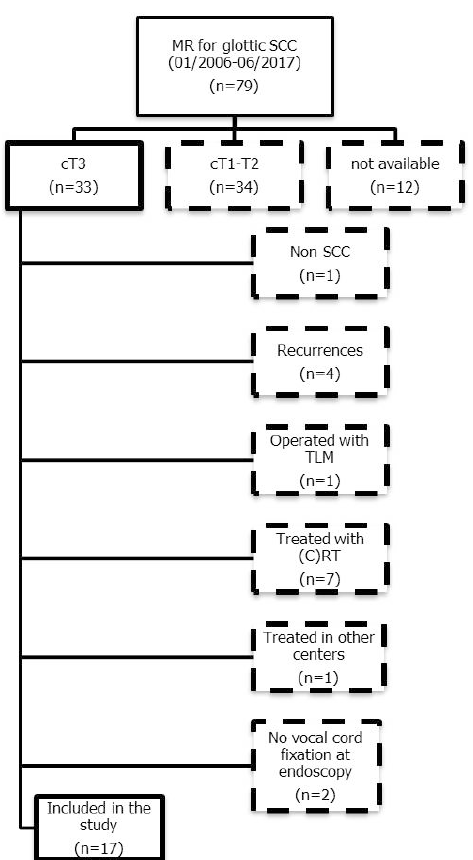
Figure 2. Selection schema: flow chart of patient enrollment in the present study. Legend: MR, magnetic resonance; SCC, squamous cell carcinoma; TLM, transoral laser microsurgery; (C)RT, (chemo)radiotherapy.